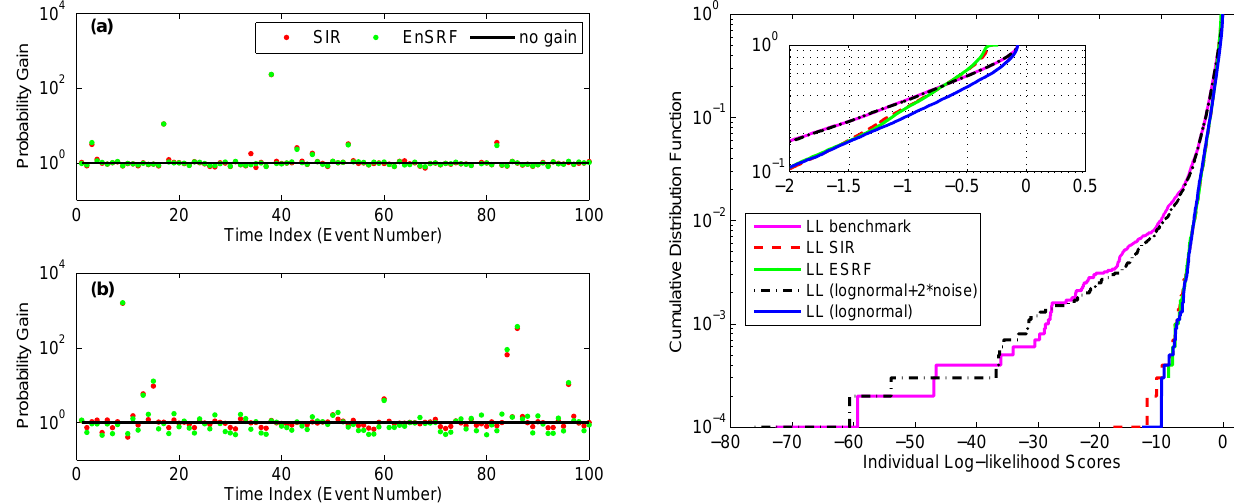
Fig. 6. Empirical cumulative distribution functions of the log- likelihood scores of each event obtained by the SIR particle filter, the EnSRF, the benchmark and the “true” (lognormal) process in a 10000-event point-process simulation. Also shown is a distribution explained in the text. Inset: magnification of the same